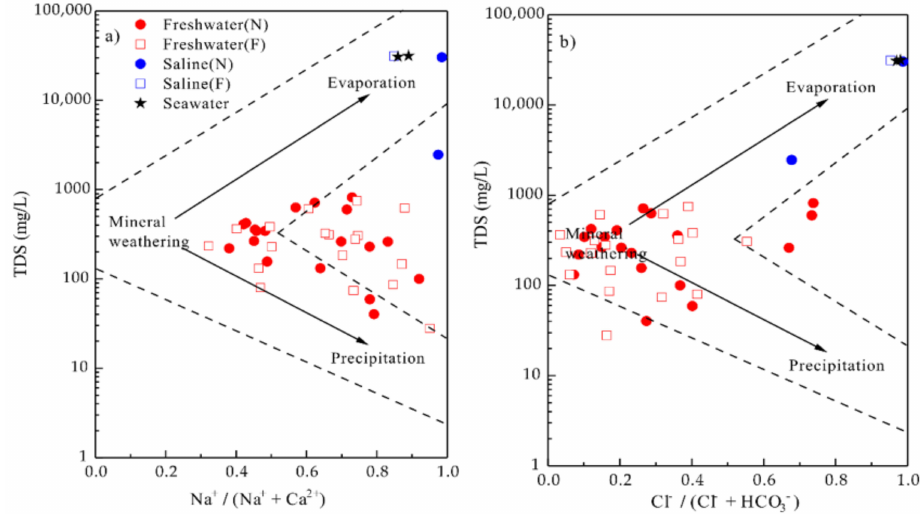
Figure 3. Gibbs chart of the coastal zone of Guangdong province. The dashed boxed areas represent the three control factors, the top for evaporation, the middle for Mineral weathering, and the bottom for Precipitation. ( a ) Cationic Gibbs figure: TDS versus Na + /Na + + Ca 2+ . ( b ) Anionic Gibbs figure: TDS versus Cl − /Cl − + HCO 3 −